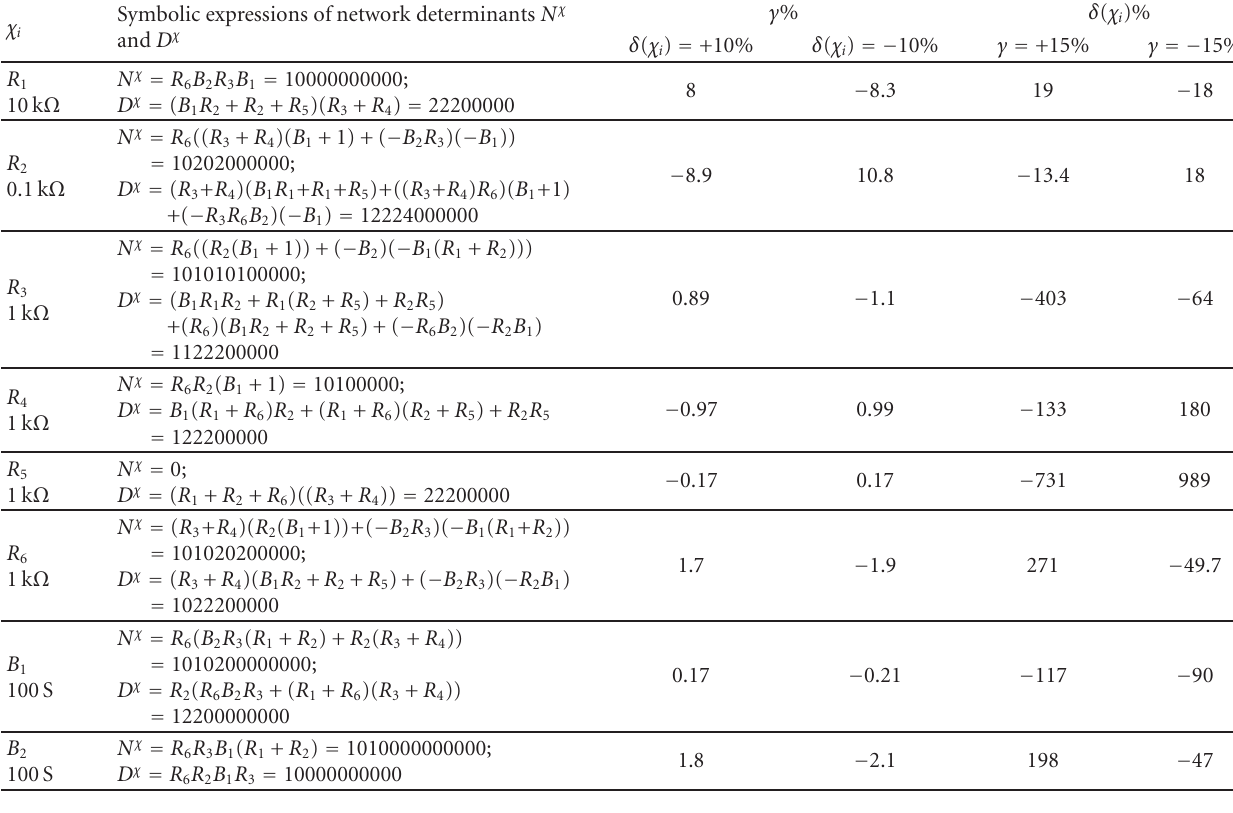
Table 1: The elements parameters of the transistor amplifier shown in Figure 2 and the results of tolerance analysis. Symbolic expressions of network determinants N χ χ i